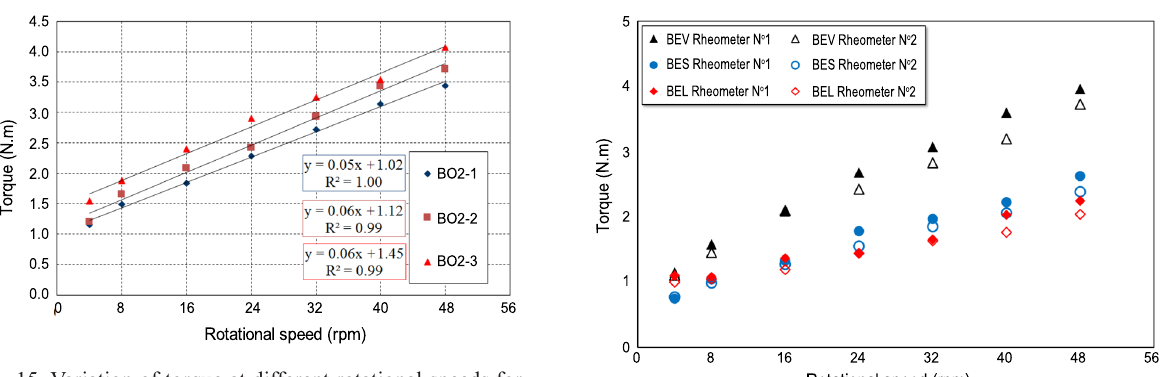
Fig. 15. Variation of torque at different rotational speeds for the repeatability test of the concrete BO2 Table 3. Variation coefficients of the rheological parameters calculated from the repetitive tests